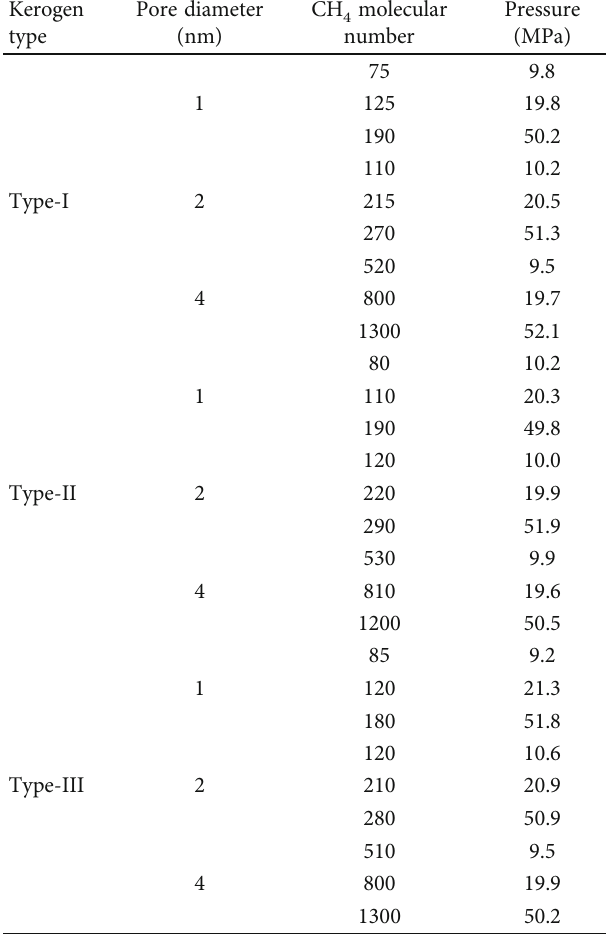
Table 2: The basic parameters of CH nanocon fi ned